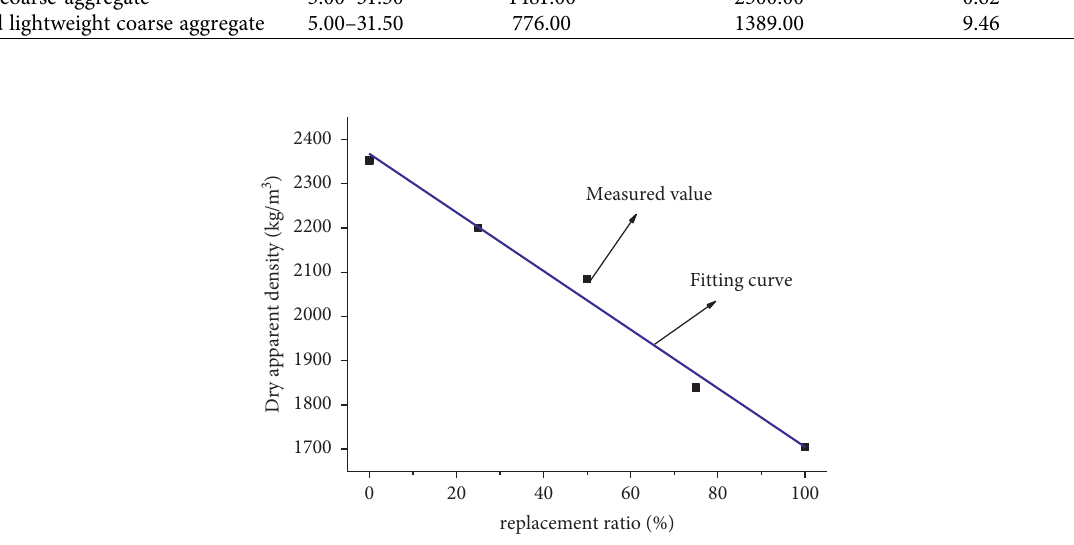
Figure 3: Relation curve between dry apparent density and replacement